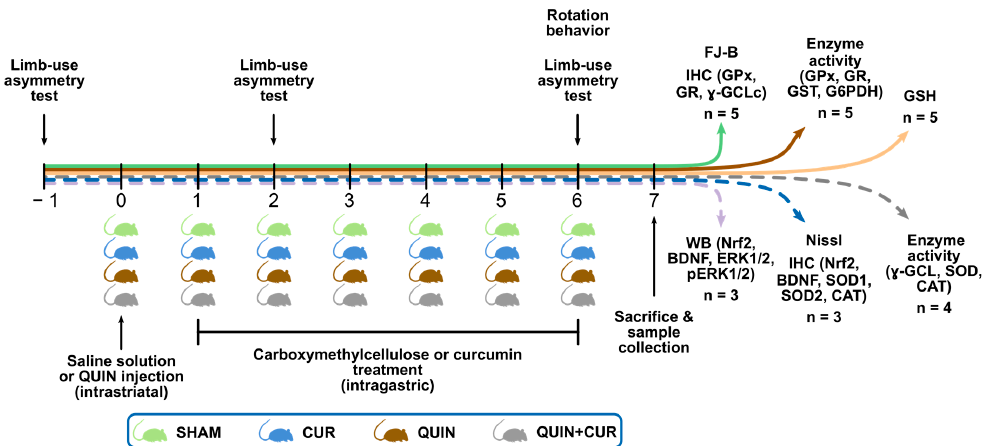
Figure 1. Experimental design. Animals were divided into four groups (day 0): SHAM, Curcumin (CUR), quinolinic acid (QUIN), and QUIN plus CUR (QUIN + CUR), and injected in the right striatum with 1 µL of saline solution (SHAM and CUR groups) or 240 nmol QUIN (QUIN and QUIN+CUR groups). Twenty-four hours after the saline solution or QUIN injections (day − 1), animals were intragastrically administered with six doses (every 24 h) of carboxymethylcelullose (SHAM and QUIN groups) or CUR (400 mg/kg) (CUR and QUIN+CUR groups). The limb-use asymmetry test was evaluated 24 h before the saline solution or QUIN administration (day − 1) and on days 2 and 6. The rotation behavior was evaluated on day 6. Horizontal solid arrows in color indicate groups of animals subjected to motor assessment. Six independents groups of animals (indicated with the horizontal arrows in color) were sacrificed (day 7) and the striatum or brains were obtained to perform the indicated assays. The number of animals (n) used in each independent group is indicated. FJ-B: fluorojade-B, GPx: glutathione peroxidase, GR: glutathione reductase, γ -GCLc: catalytic subunit of γ -glutamylcysteine ligase, GST: glutathione S-transferase, G6PDH: glucose 6 phosphate dehydrogenase, SOD1: superoxide dismutase 1, SOD2: superoxide dismutase 2, CAT: catalase, GSH: reduced glutathione, Nrf2: nuclear factor erythroid 2-related factor 2, BDNF: brain-derived neurotropic factor, ERK1 / 2: mitogen activated kinase-1/2, p-ERK1/2: phosphorylated ERK1/2, IHC: immunohistochemistry, WB: Western blot.